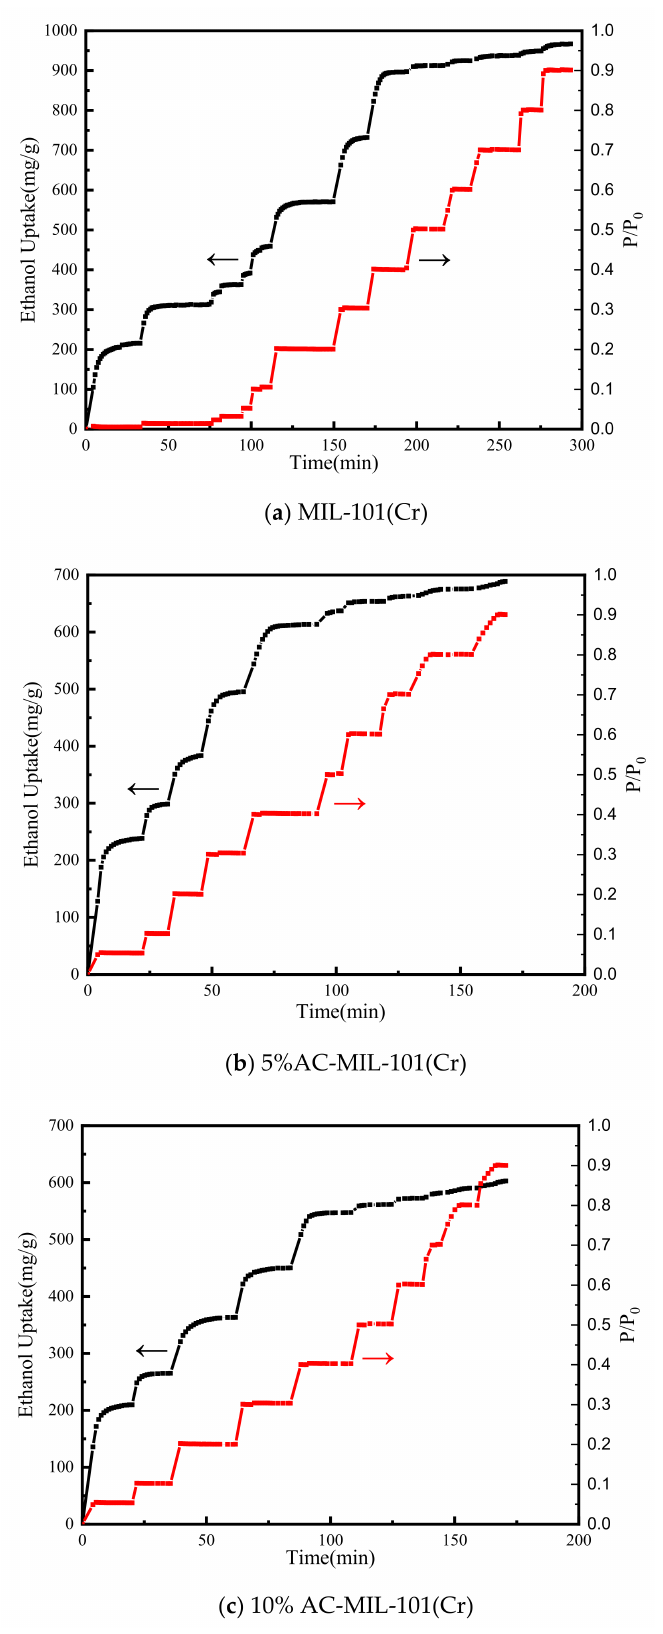
Figure 8. Ethanol vapor adsorption kinetic curves of adsorbent materials at 303 K: ( a )